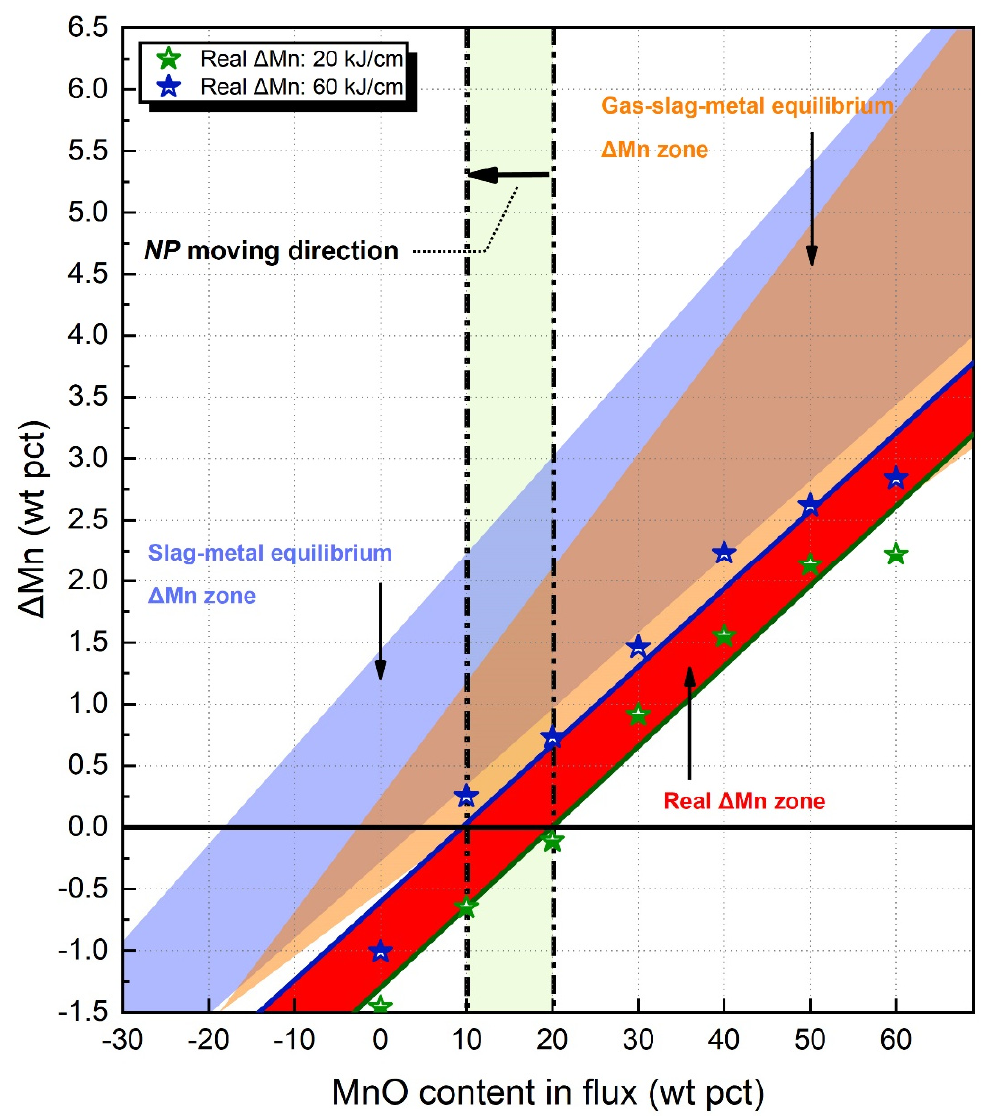
Figure 3. The real NPs calculated as a function of MnO content in flux.